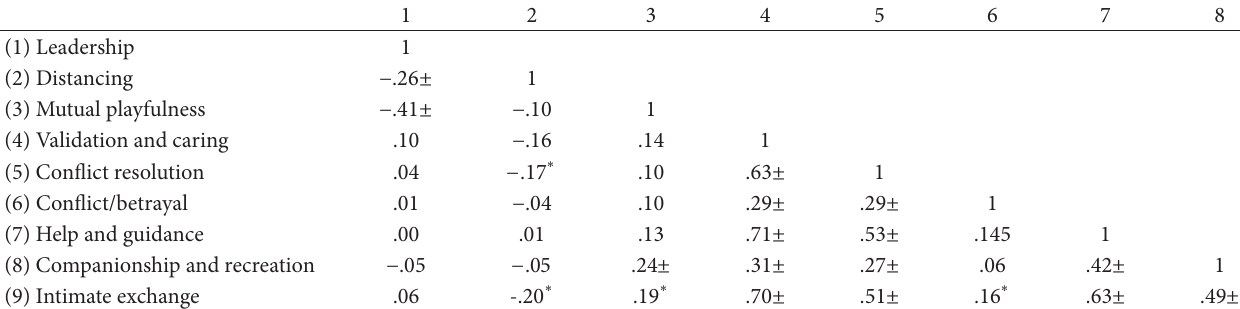
T 5: Pearson correlations: associations among adolescent friendship behavior types and friend-rated friendship qualities